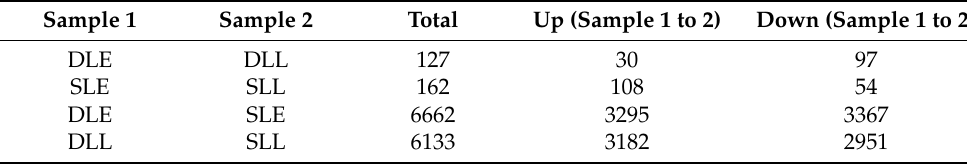
Figure 2. Analysis of the differentially expressed genes between samples. X-axis indicates the mean expression of the compared genes. Y-axis indicates the log2 fold of the compared genes. Red dots indicate differentially expressed genes. Gray dots indicate non-differentially expressed genes. Table 2. Number of the differentially expressed genes.